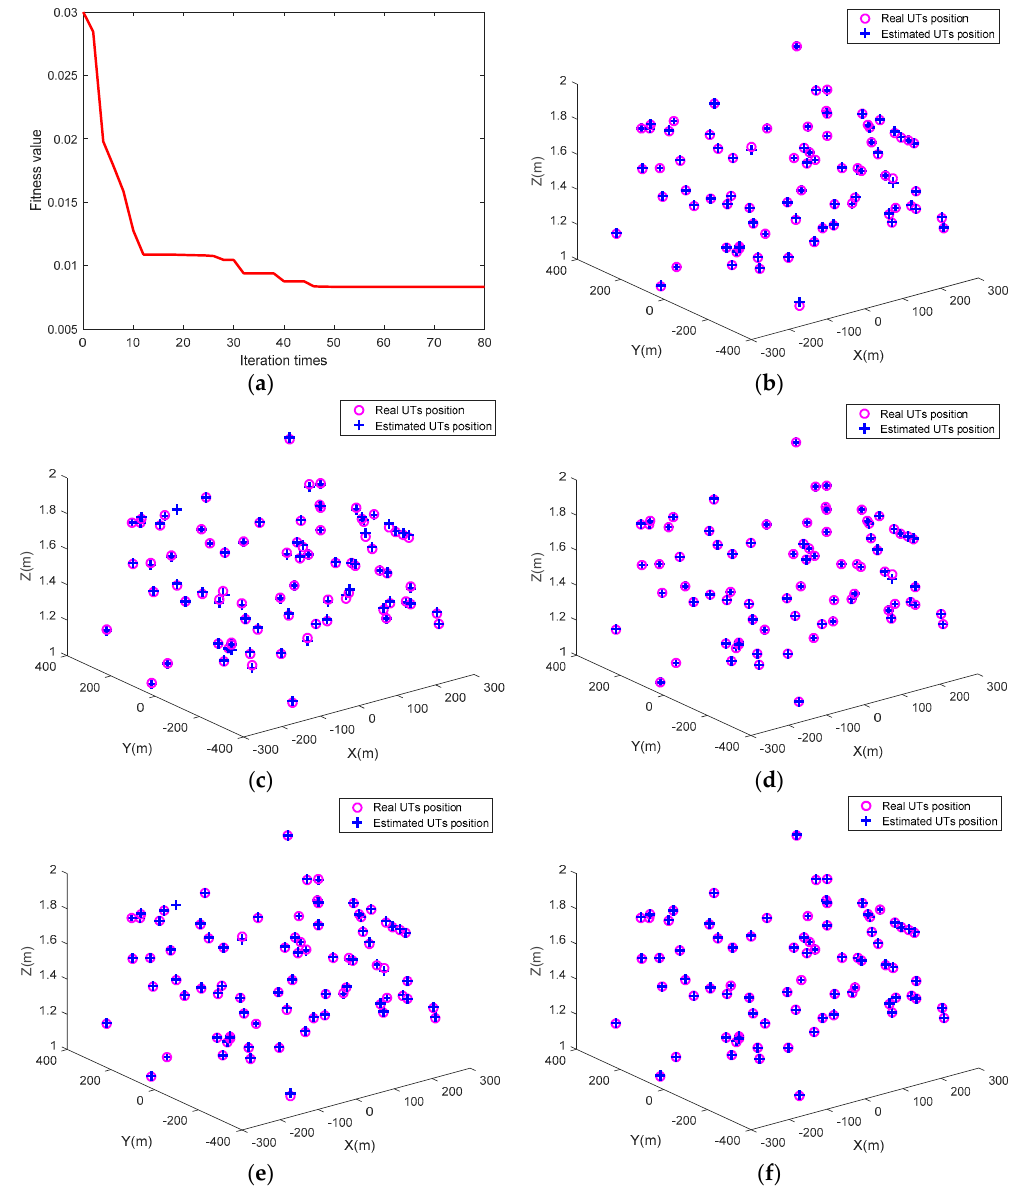
Figure 3. The distribution of the real position and its estimated 3 ‐ D position. ( a ) The relationship between iteration times and the best fitness of the particle swarm; ( b ) positioning results based on PSO model; ( c ) initial calculation results based on the Chan algorithm; ( d ) re ‐ calculation results based on the Chan algorithm; ( e ) initial calculation results based on the PSO algorithm; and ( f ) re ‐ calculation results based on the proposed PSO ‐ IMChan algorithm.